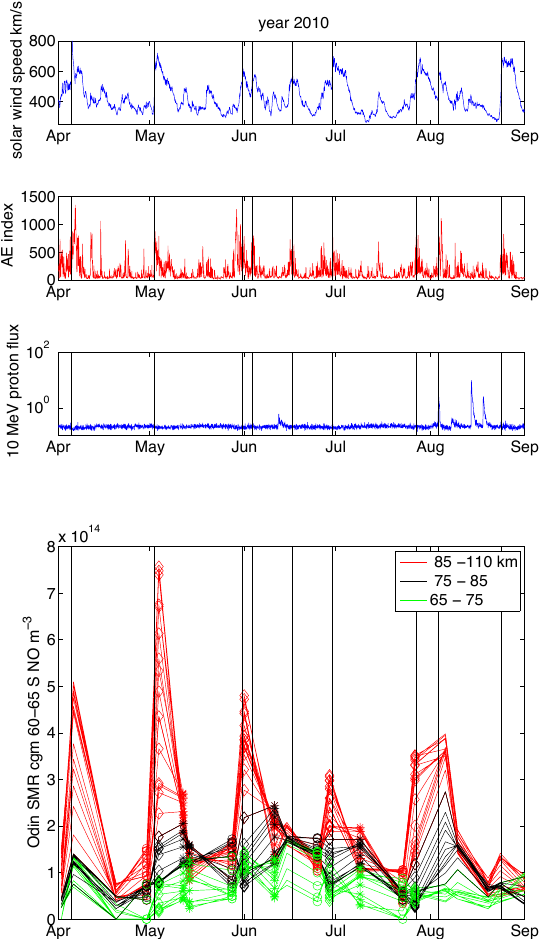
Figure 5. Observations of 24h averaged NO number densities in the 60–65 ◦ S geomagnetic latitude band by the Odin-SMR instru- ment (bottom panel) associated with the arrival of high-speed so- lar wind streams (top panel) during austral winter in 2010. Middle panels show the auroral electrojet index and the flux of 10MeV protons (from http://omniweb.gsfc.nasa.gov/). Vertical lines mark the times of arrival of high-speed solar wind streams (“onset”). Ob- servations used in Figs. 6 and 7 are marked by open circles (pre- onset), diamonds (onset or immediately post-onset) and asterisks (about 10 days after